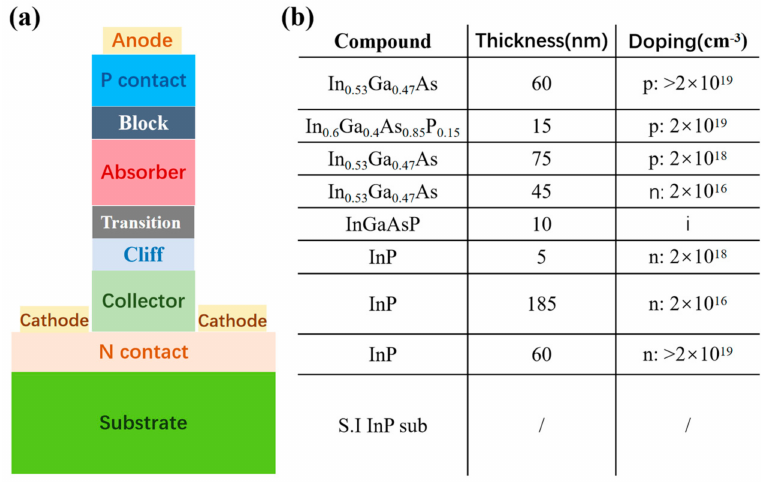
Figure 3. Schematic diagram ( a ) and epitaxial design ( b ) of the MUTC–PD